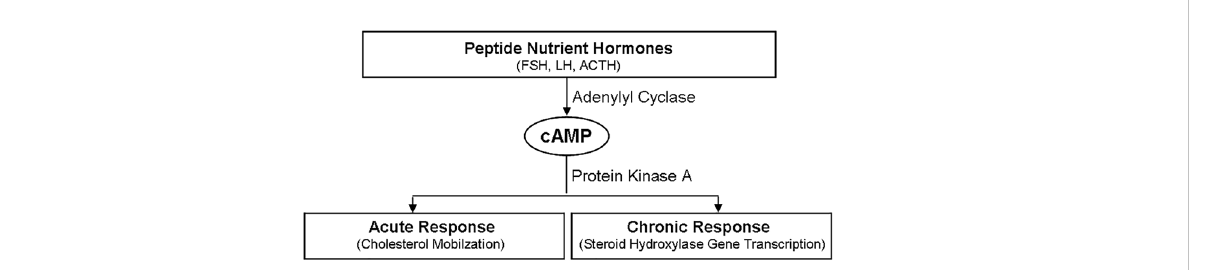
FIGURE 3 Regulatory Effects of peptide hormones on steroidogenesis. Peptide hormones, such FSH, LH and ACTH, initiate the synthesis of steroid hormones through cAMP/PKA signaling pathway, which includes two different time stages. One is the acute response stage, which is characterized by cholesterol mobilization. And the other is the chronic response stage, which is characterized by steroid hydroxylase gene transcription. FSH, follicle stimulating hormone; LH, luteinizing hormone; ACTH, adreno-cortico-tropic-hormone; PKA, protein kinase A; cAMP, cyclic adenosine